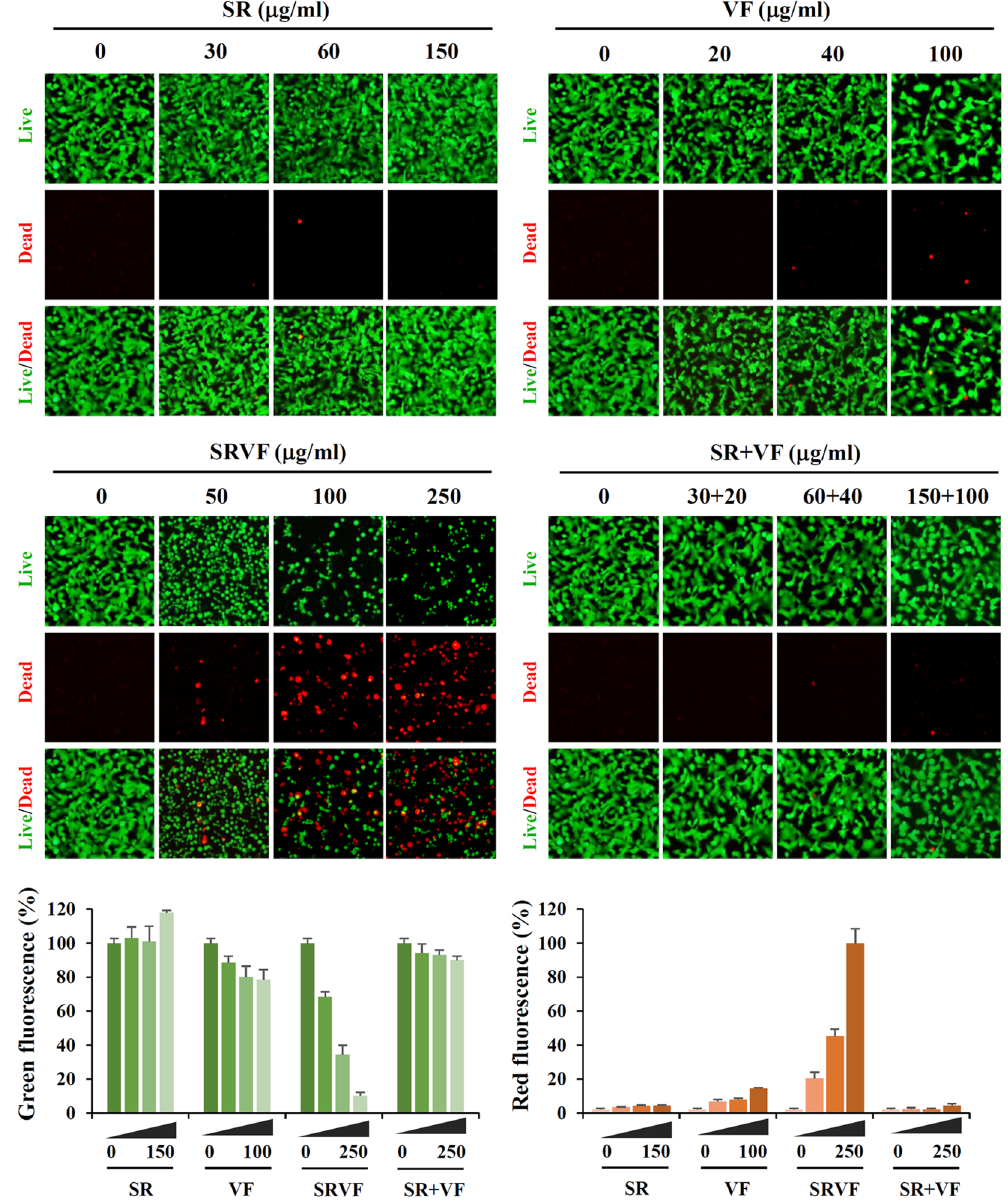
Figure 3. SRVF causes severe cytotoxicity in HT1080 cells. After incubating cells with the indicated concentrations of SR, VF, or SRVF for 24 h, live and dead cells were examined under a fluorescence microscope using the LIVE/DEAD Cell Imaging Kit. Data are expressed as the mean ± SD of five random fields per sample and are representative of three independent